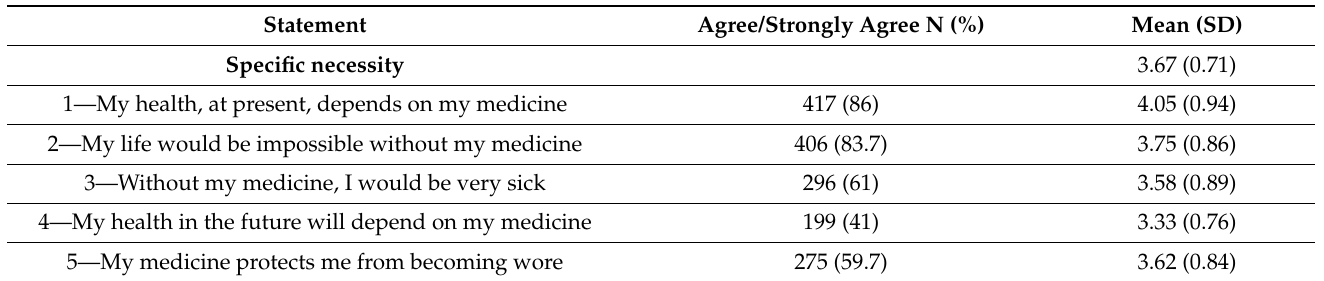
Table 3. Responses to the BMQ items (specific necessity and specific